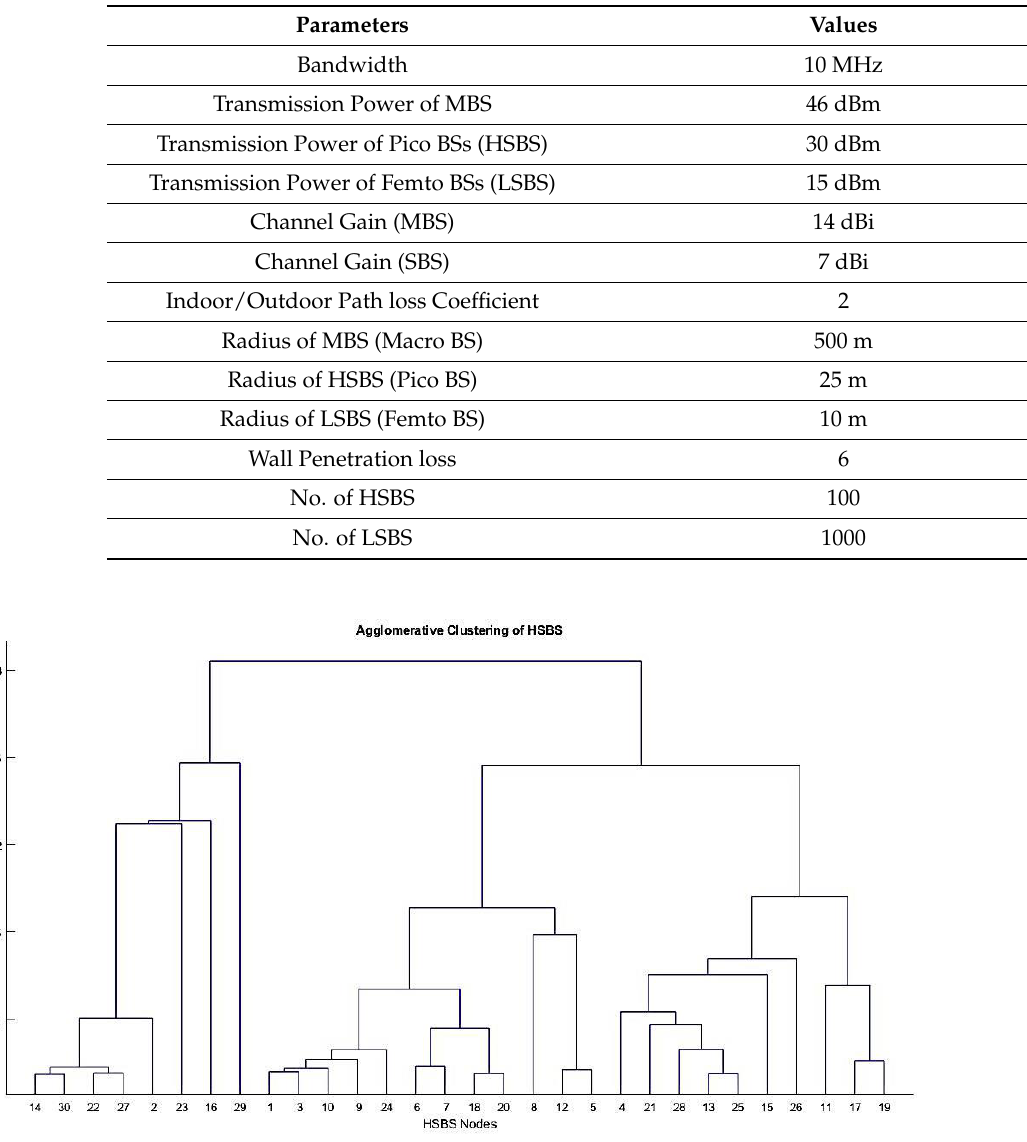
Table 3. Simulation parameters.